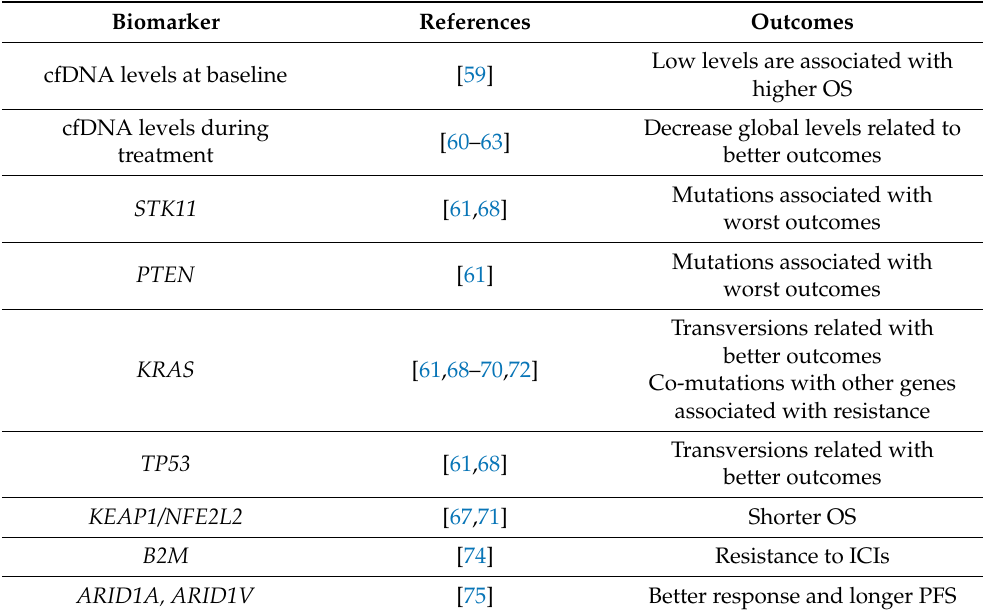
Table 4. Circulating free DNA studies evaluating the potential of its levels or mutated individual genes as predictors of ICI response and the association with patients’